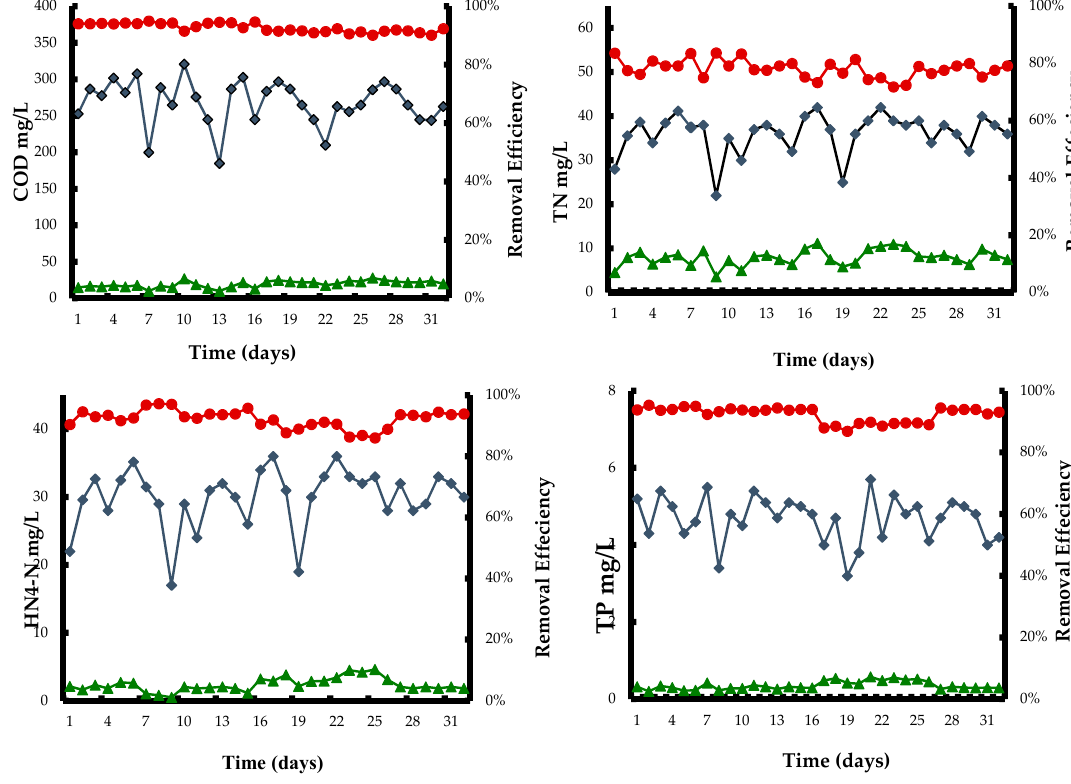
Figure 6. Removal efficiency of COD, TN, NH 4 + –N, and TP in A2O–wetland system. Influent water; Effluent water; COD removal efficiency.